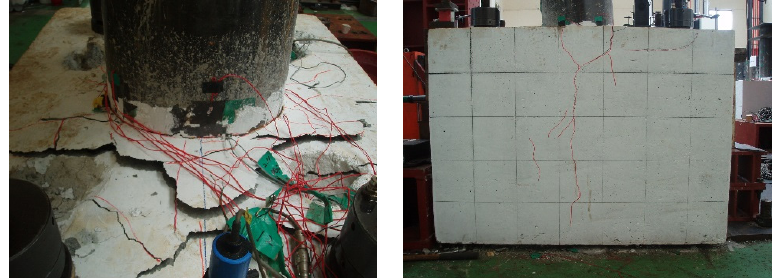
Figure 8. Failure mode of Specimen PO_D10_L6.